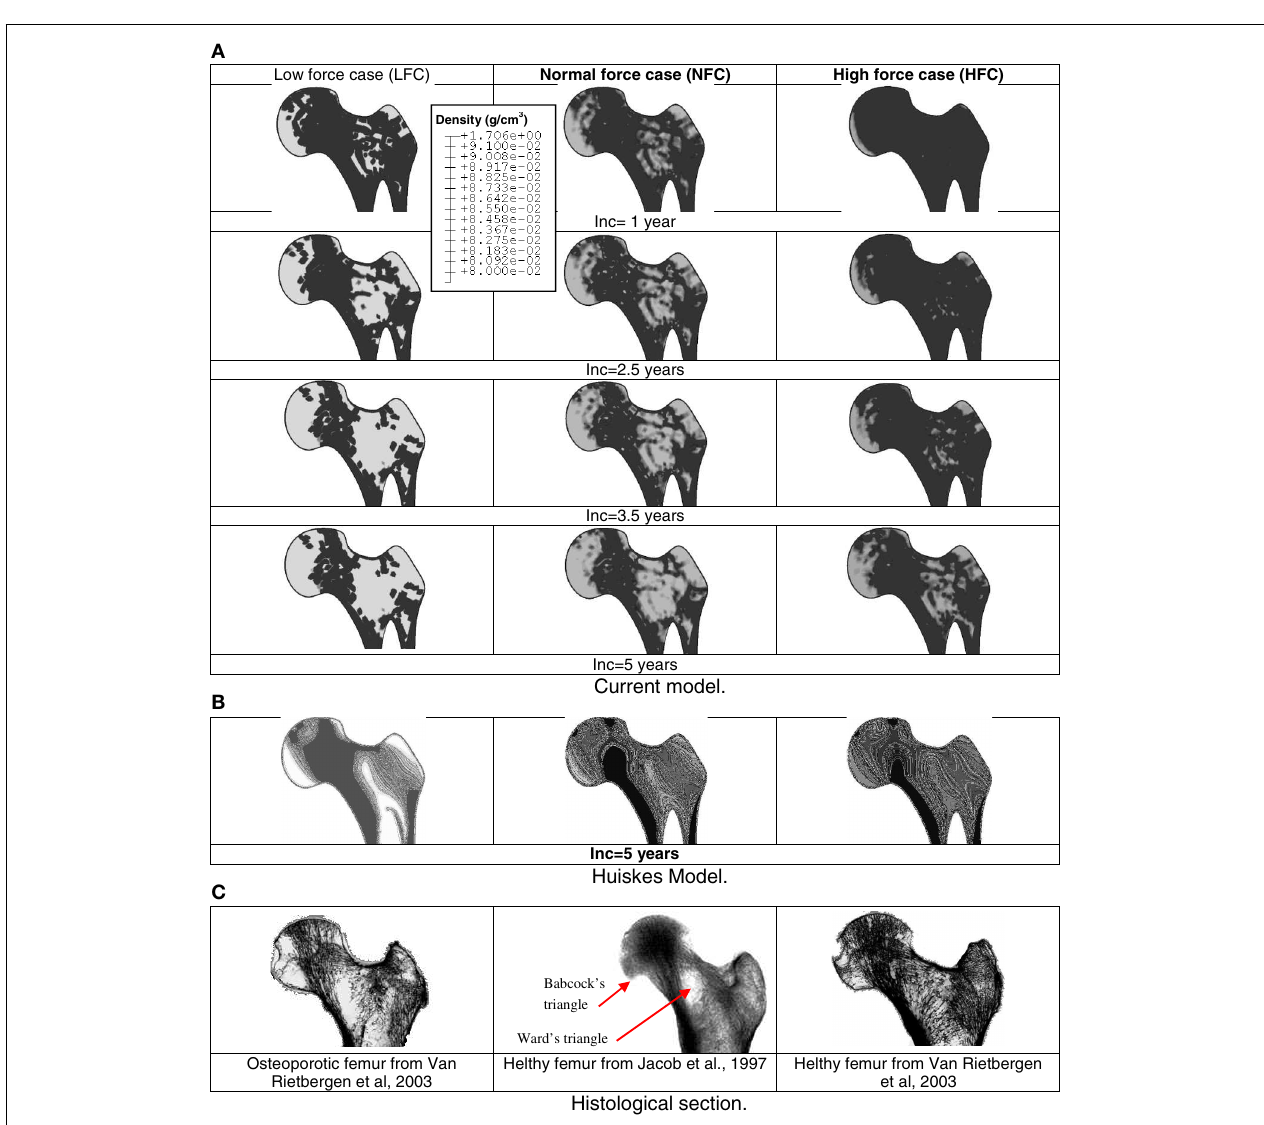
the current mechanobiological model, (B) prediction based on classic phenomenological remodeling approach of Huiskes (Huiskes et al., 1987; Ruimerman et al., 2005). (C) Histological proximal femur sections from the